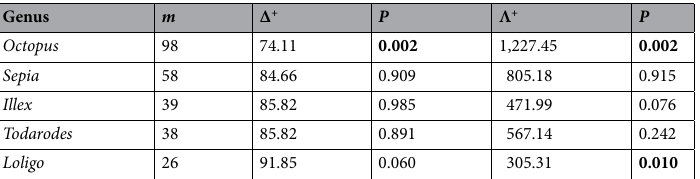
Table 1. Results of tests comparing Δ + and Λ + values calculated for parasite assemblages hosted by the cephalopod genera Octopus , Sepia , Illex , Todarodes and Loligo , with the corresponding frequency distribution obtained from 1,000 random simulations of a subset of the same number of species m from the full list of 309 parasite species recorded at global scale. Significant results are given in bold. Analysis was done using the software package PRIMER v6 70